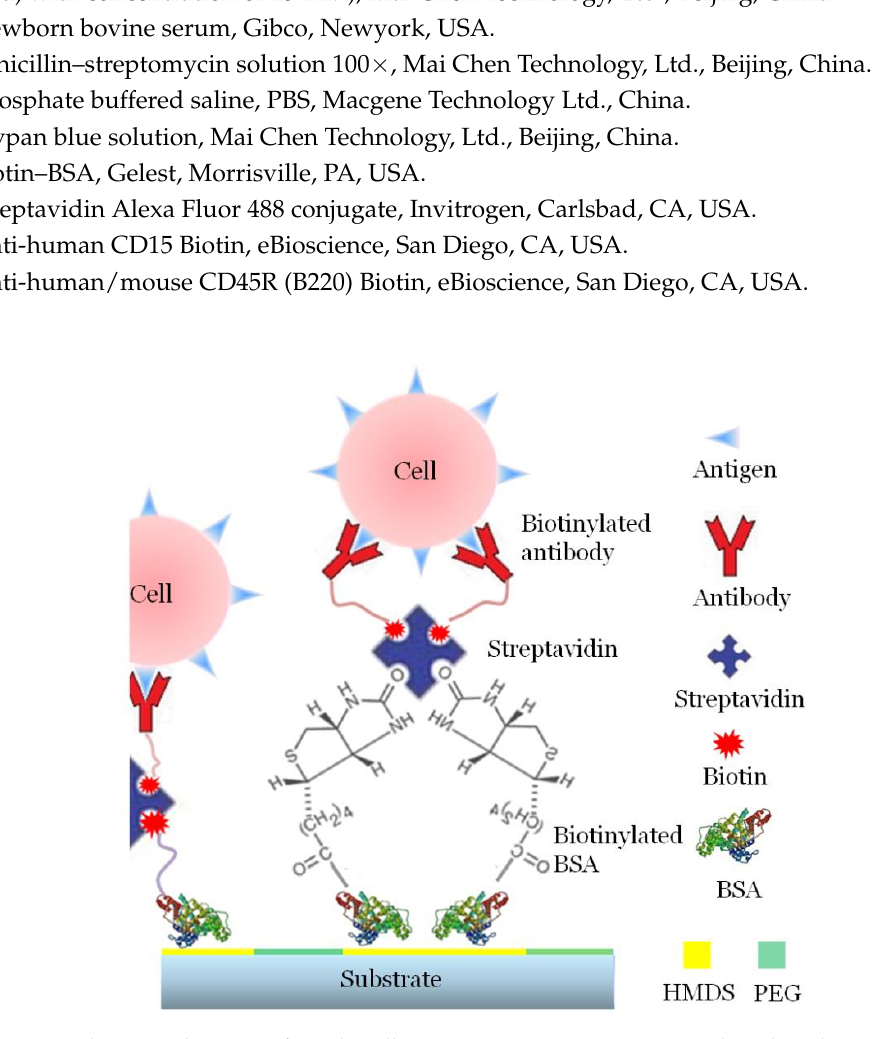
Figure 7. Schematic diagram of single cell patterning. Biotin–BSA is employed as the underlying adhesive proteins. Streptavidin is the middle template layer to provide further binding sites for the bonding of the antibodies. Based on the specific immune reaction between antigens and antibodies, the HL 60 cells can be further captured on the surface of the substrate.